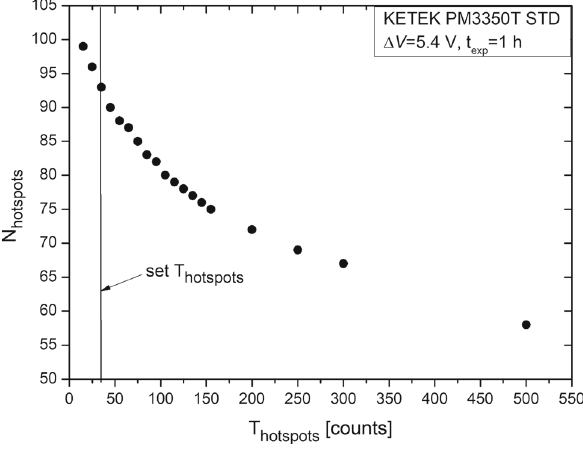
Fig. 10 Dependence of N hotspots on T hotspots